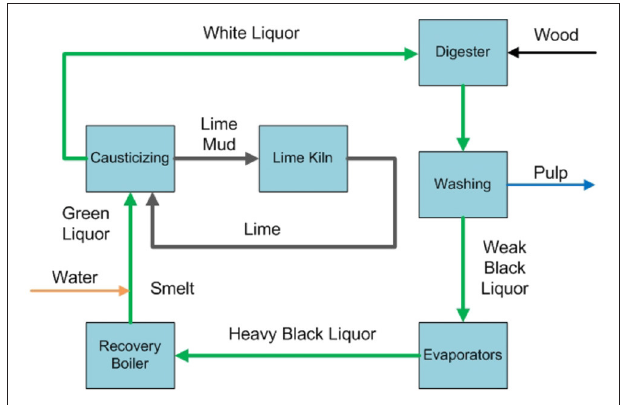
FIGURE 1 | Typical chemical (sodium and lye/lime) recovery process in the Kraft pulping